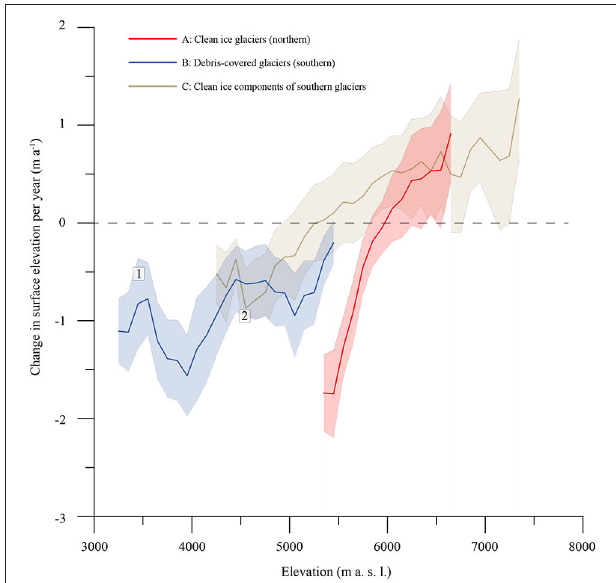
FIGURE 4 | A comparison between elevation and the mean elevation change per 100m elevation band between 2000 and 2013. Different responses to elevation are visible for the clean glaciers in the northern section of the study area (line A), the debris-covered components of the glaciers in the southern section of the study area (line B), and clean ice components of the southern glaciers (line C). Two noticeable deviations in the melt-rate (1, 2) are attributed to insulation of ice due to the build-up of supraglacial debris. The shaded areas represent one standard deviation of each elevation interval.